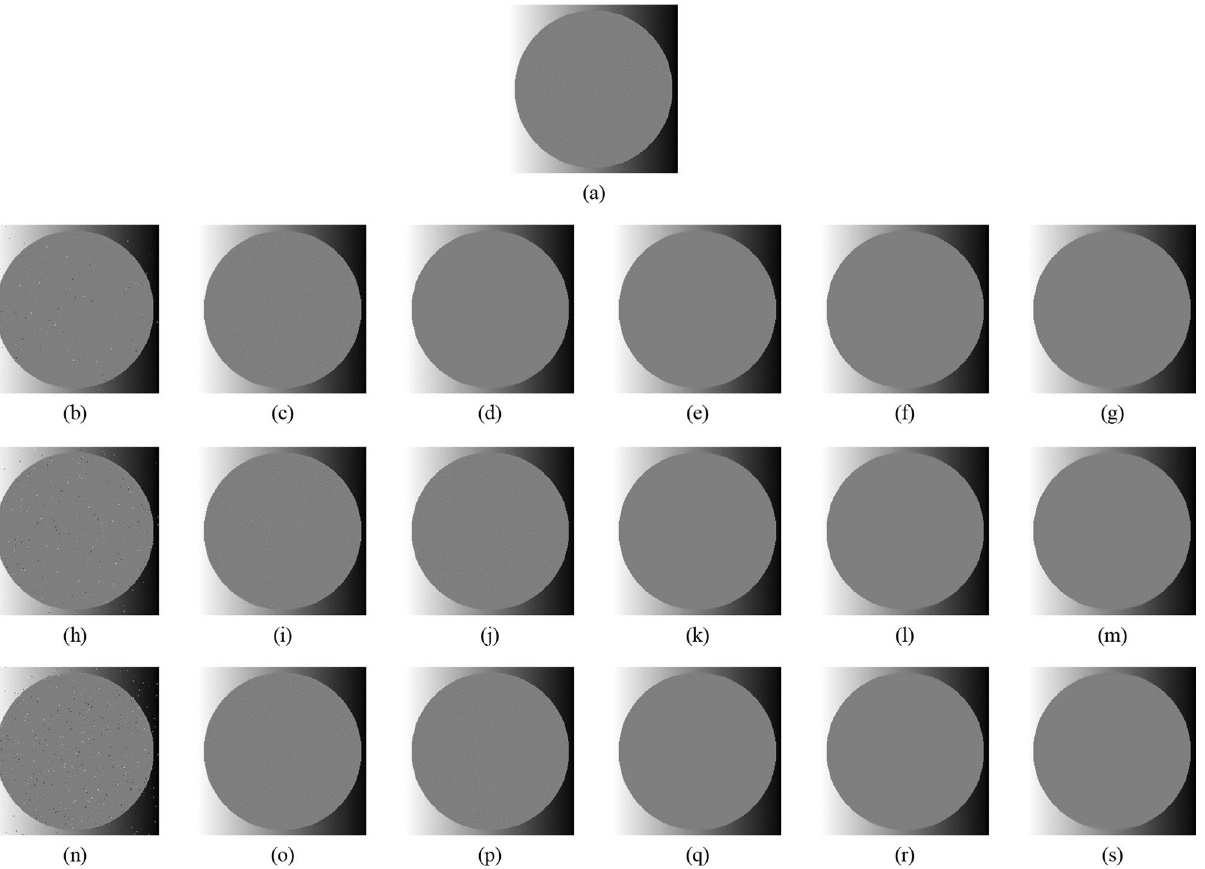
Figure 4. Comparison of noise reduction performance of each filter size and each noise level. ( a ) Original image; ( b ) noise-added image (Noise level = 0.1%); ( c ) filtered image using abwFMGFI (noise level = 0.1%, filter size = 3 × 3); ( d ) filtered image using abwFMGFI (noise level = 0.1%, filter size = 5 × 5); ( e ) filtered image using abwFMGFI (noise level = 0.1%, filter size = 7 × 7); ( f ) filtered image using abwFMGFI (noise level = 0.1%, filter size = 9 × 9); ( g ) filtered image using abwFMGFI (noise level = 0.1%, filter size = 11 × 11); ( h ) noise-added image (noise level = 0.3%); ( i ) filtered image using abwFMGFI (noise level = 0.3%, filter size = 3 × 3); ( j ) filtered image using abwFMGFI (noise level = 0.3%, filter size = 5 × 5); ( k ) filtered image using abwFMGFI (noise level = 0.3%, filter size = 7 × 7); ( l ) filtered image using abwFMGFI (noise level = 0.3%, filter size = 9 × 9); ( m ) filtered image using abwFMGFI (noise level = 0.3%, filter size = 11 × 11); ( n ) noise-added image (noise level = 0.5%); ( o ) filtered image using abwFMGFI (noise level = 0.5%, filter size = 3 × 3); ( p ) filtered image using abwFMGFI (noise level = 0.5%, filter size = 5 × 5); ( q ) filtered image using abwFMGFI (noise level = 0.5%, filter size = 7 × 7); ( r ) filtered image using abwFMGFI (noise level = 0.5%, filter size = 9 × 9); ( s ) filtered image using abwFMGFI (noise level = 0.5%, filter size = 11 × 11).